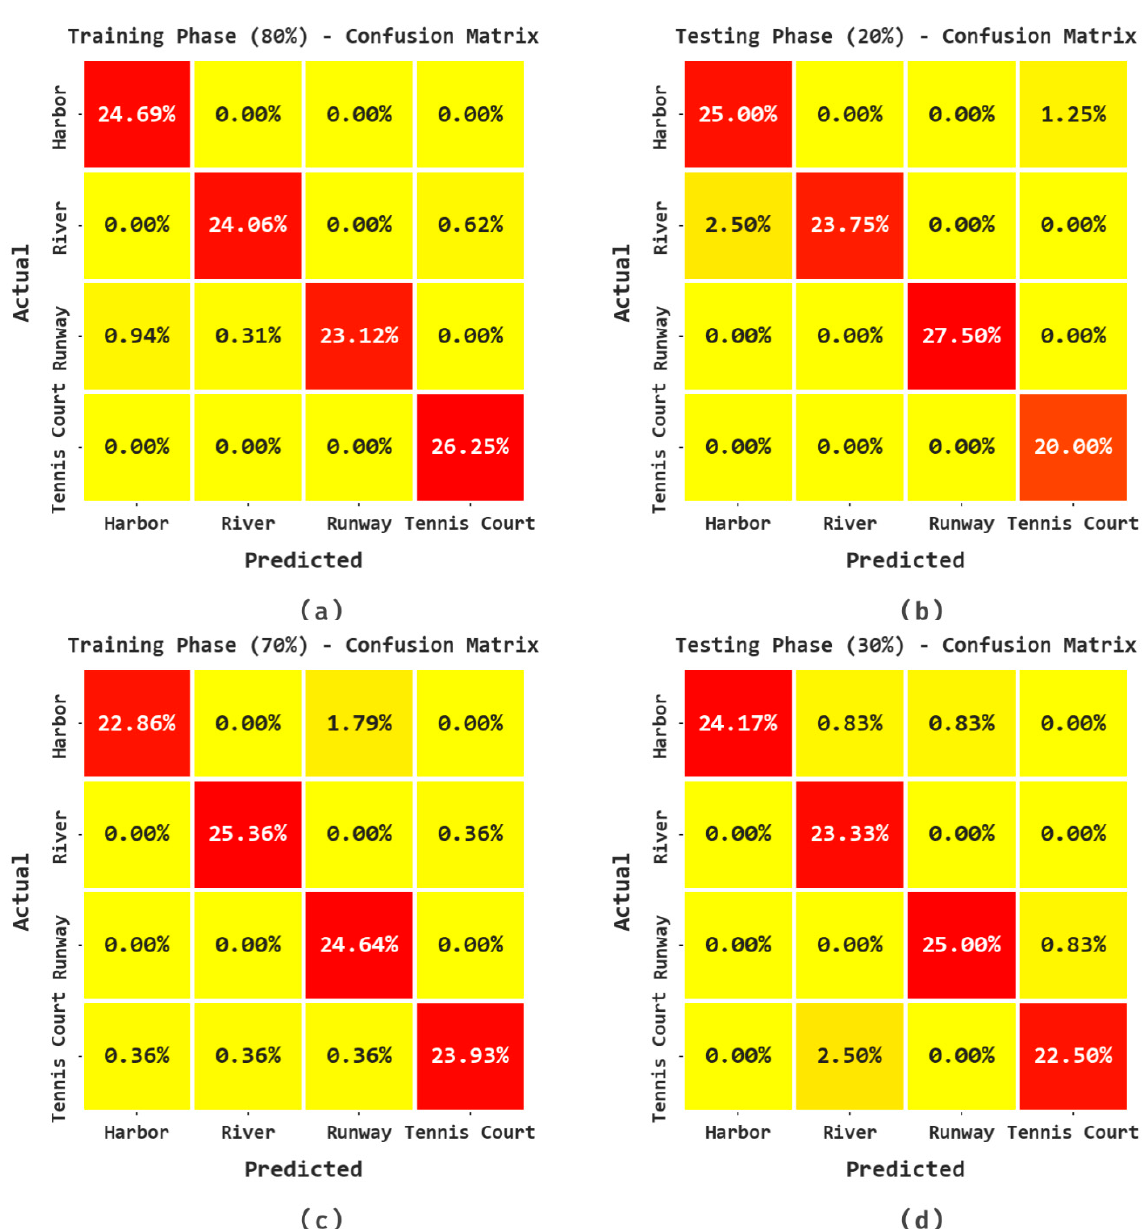
Figure 6. Confusion matrices of the BSBE-PPODLC approach: ( a , b ) TR and TS databases of 80:20; ( c , d ) TR and TS databases of 70:30. Table 4 and Figure 7 represent the classification performance of the BSBE-PPODLC model on 80:20 of TR/TS data. The obtained values show that the BSBE-PPODLC algo- Table 4. Classification outcomes of the proposed BSBE-PPODLC approach on 80:20 TR/TS rithm identified all the class labels on the RSIs. For example, with 80% of the TR database, the BSBE-PPODLC technique accomplished an average 𝑎𝑐𝑐𝑢 (cid:3052) of 99.06%, 𝑝𝑟𝑒𝑐 (cid:3041) of 98.18%, 𝑟𝑒𝑐𝑎 (cid:3039) of 98.09% and an 𝐹 (cid:3046)(cid:3030)(cid:3042)(cid:3045)(cid:3032) of 98.10%. Moreover, with 20% of the TS database, the BSBE-PPODLC method attained an average 𝑎𝑐𝑐𝑢 (cid:3052) of 98.12%, 𝑝𝑟𝑒𝑐 (cid:3041) of 96.26%, 𝐹 𝑟𝑒𝑐𝑎 (cid:3039) of 96.43 % and an (cid:3046)(cid:3030)(cid:3042)(cid:3045)(cid:3032) of 96.25%.